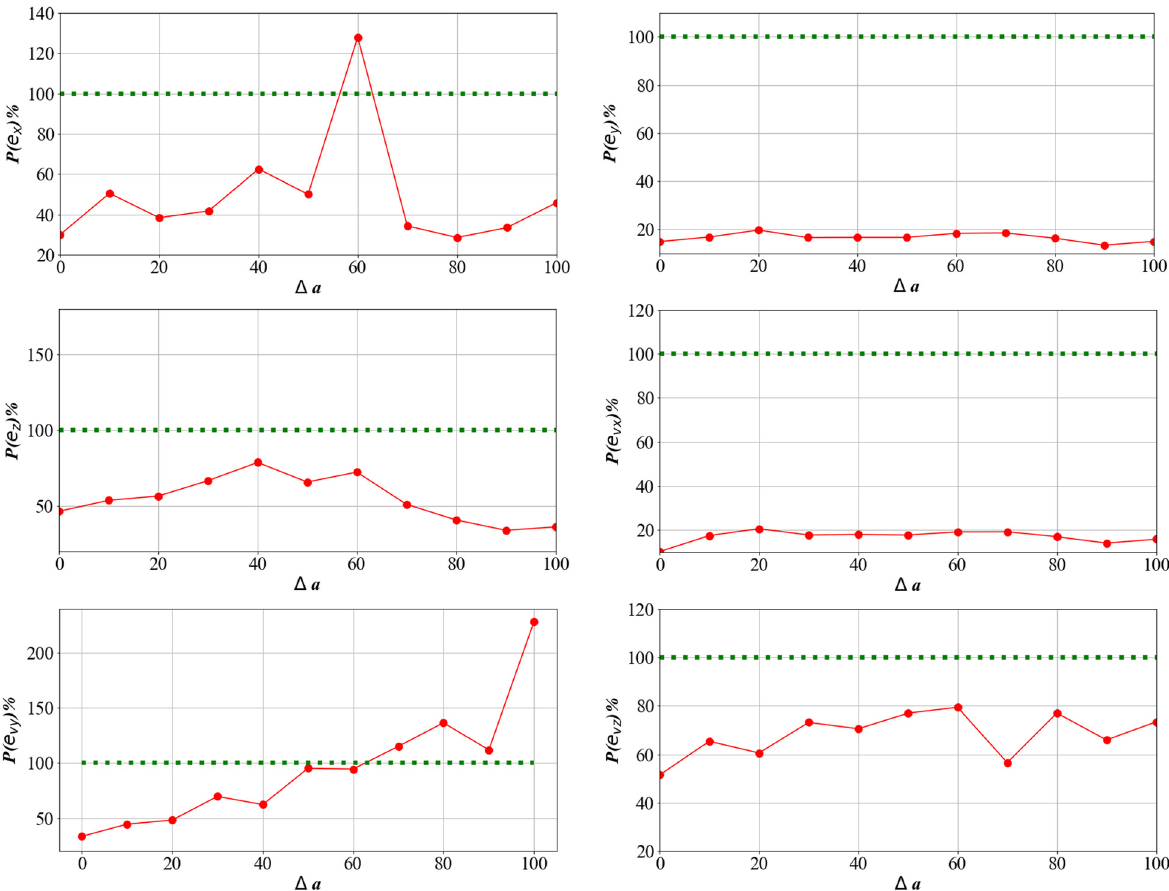
Figure 8: Generalization performance of PCA – XGBoost training on original satellite and testing on satellites with di ff erent semi - major